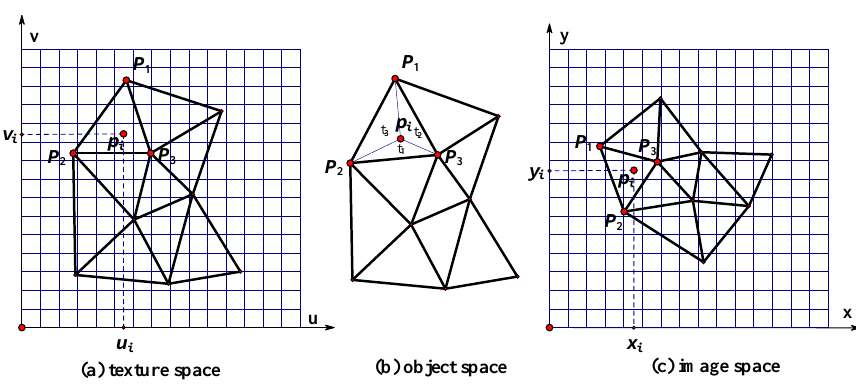
Fig.2. Mesh resample for high-resolution texture generation